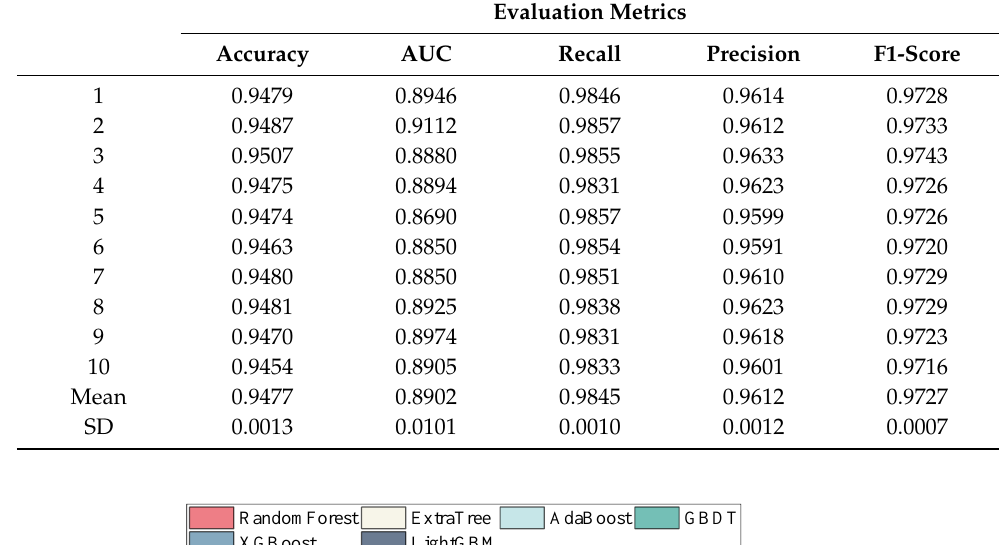
Table 9. The 10-fold cross-validation results for LightGBM.